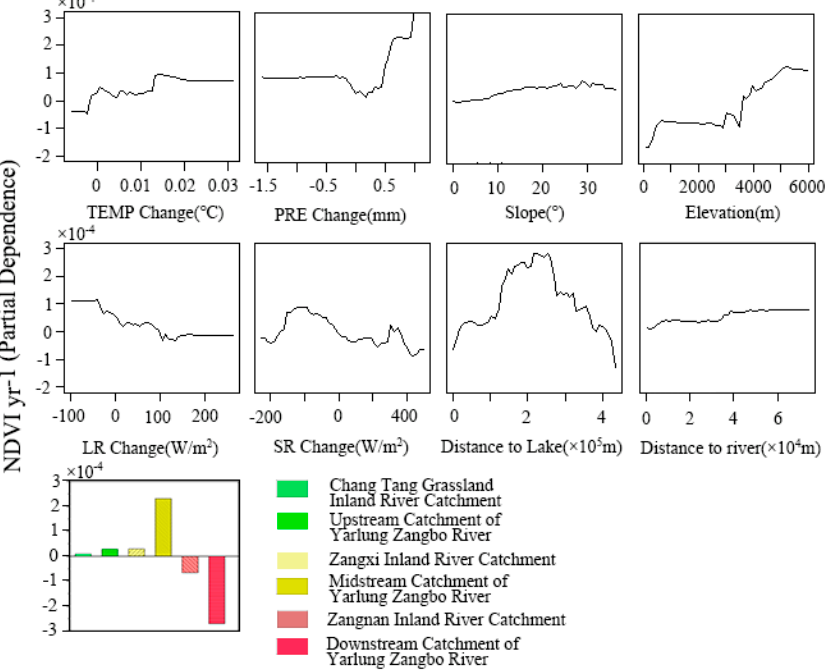
Figure 6. Partial dependence plots of nine environment factors for the whole HEM region. These plots represent the influence of environmental factors (x-axis) on the interannual NDVI trend (y-axis).